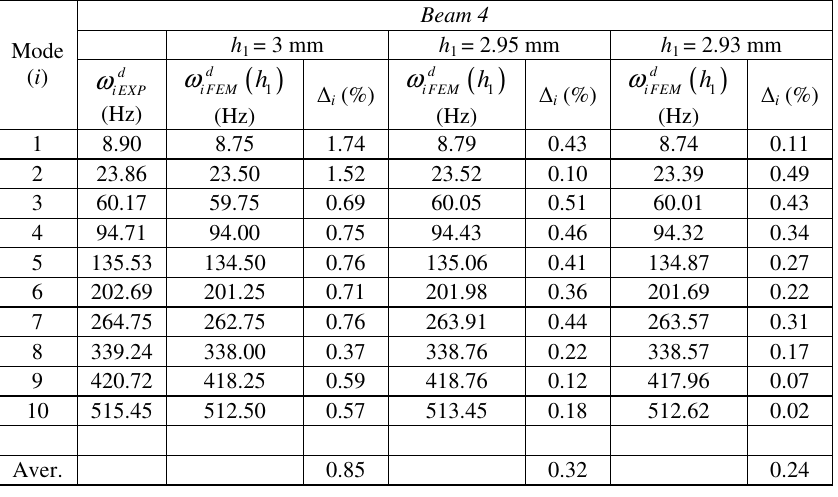
Table 6. Flexural frequencies and residuals for the Beam 4 calculated using identified damage